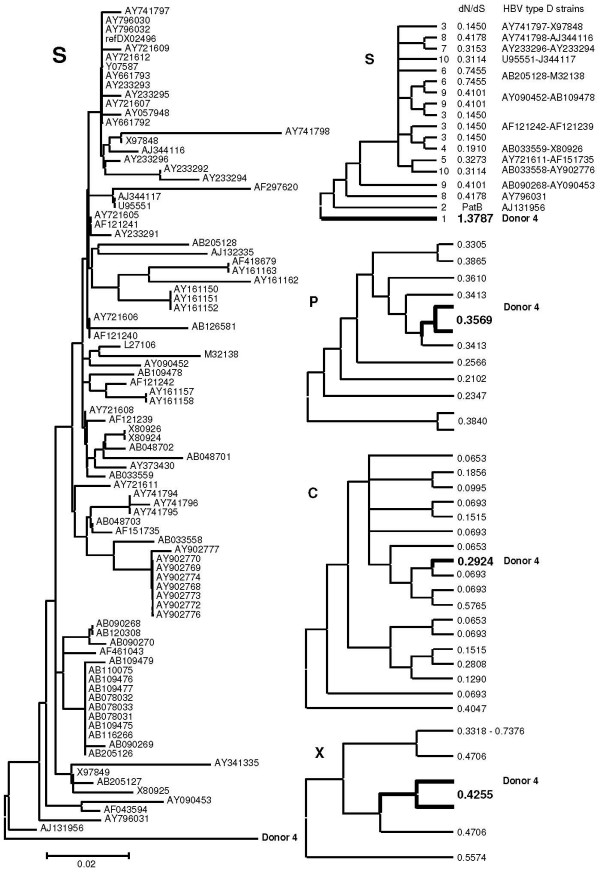
HBV strain phylogeny. A bootstrap consensus tree based on JTT-estimates of amino acid replacements in surface proteins of HBV genotype D displays the surface protein of donor 4 carrying an occult infection in the outgroup position (left panel). The scale bar indicates 2% of evolutionary divergence. For phylogenetic analysis by maximum likelihood, the HBV type D strains were grouped according to their topological position, approximately and provided with labels as indicated next to the branches of the compressed topology tree (right panel, S). The corresponding values obtained for dN/dS are in between of the labels and strains columns; PatB means ''parameter at boundary''. Data on donor 4 are in bold-face. The three panels marked by P(olymerase), C(ore) and X were constructed in a similar fashion, but without mentioning GenBank IDs and clade/branch labels. In case of P and X, the donor 4 species was combined with its nearest neighbor in order to avoid deviation due to insufficient branch length.